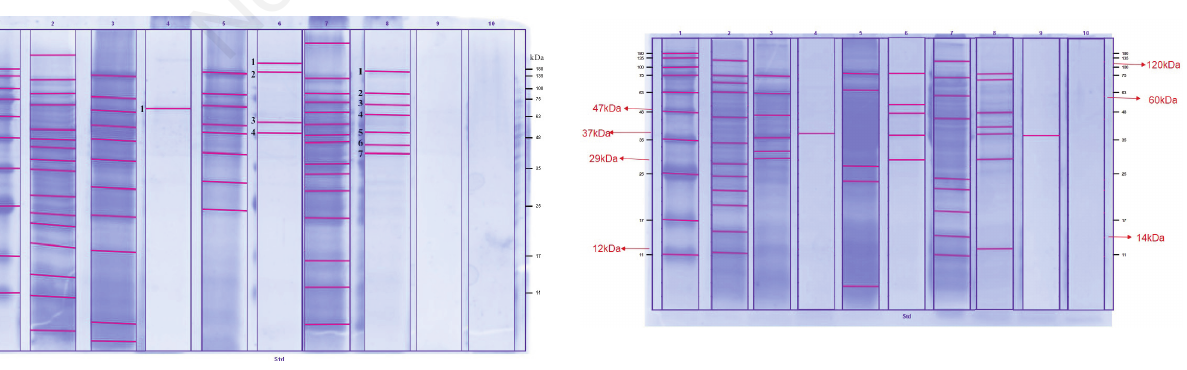
Figure 2. Results of electrophoresis. kDa = molecular weight in kilo dalton, lane 1 = marker, lane 2 = standard (planktonic), lane 3 = glucose-induced pellet, lane 4 = glucose-induced biofilm, lane 5 = lactose-induced pellet, lane 6 = lactose-induced biofilm, lane 7 = soy protein-induced pellet, lane 8 = soy protein-induced biofilm, lane 9 = iron-induced pellet, lane 10 = iron-induced